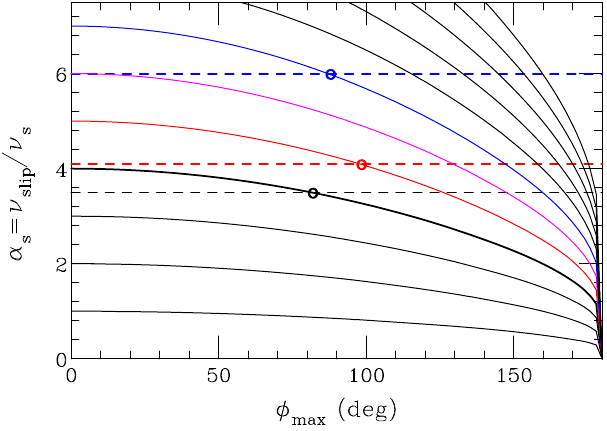
FIG. 6. The synchrotron tune and its harmonics of a stationary rf system versus ϕ , the maximum phase amplitude of max synchrotron oscillation. The horizontal dashed lines are modu- lation tunes at various slip-stacking parameters. When they cut through an n th harmonic of the synchrotron tune, the n th-order resonance will occur at that phase-space amplitude. These are the resonances visible in Figs. 3 – 5.